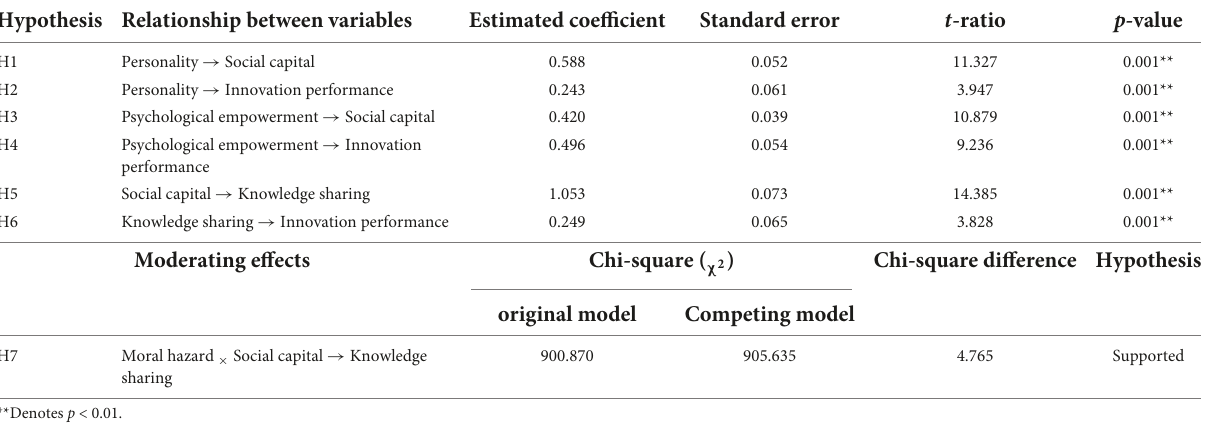
TABLE 6 Estimation results of linear structural equation modeling.